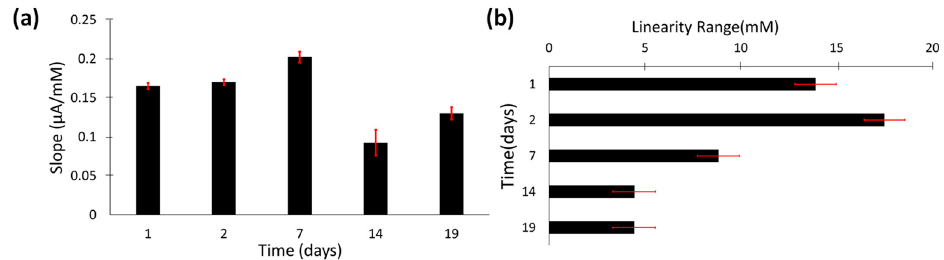
Figure 5. Clark-type LDH-catalase enzyme biosensor response vs. H 2 O 2 substrate concentration. ( a ) Slope and ( b ) linearity range values as a function of lifetime.